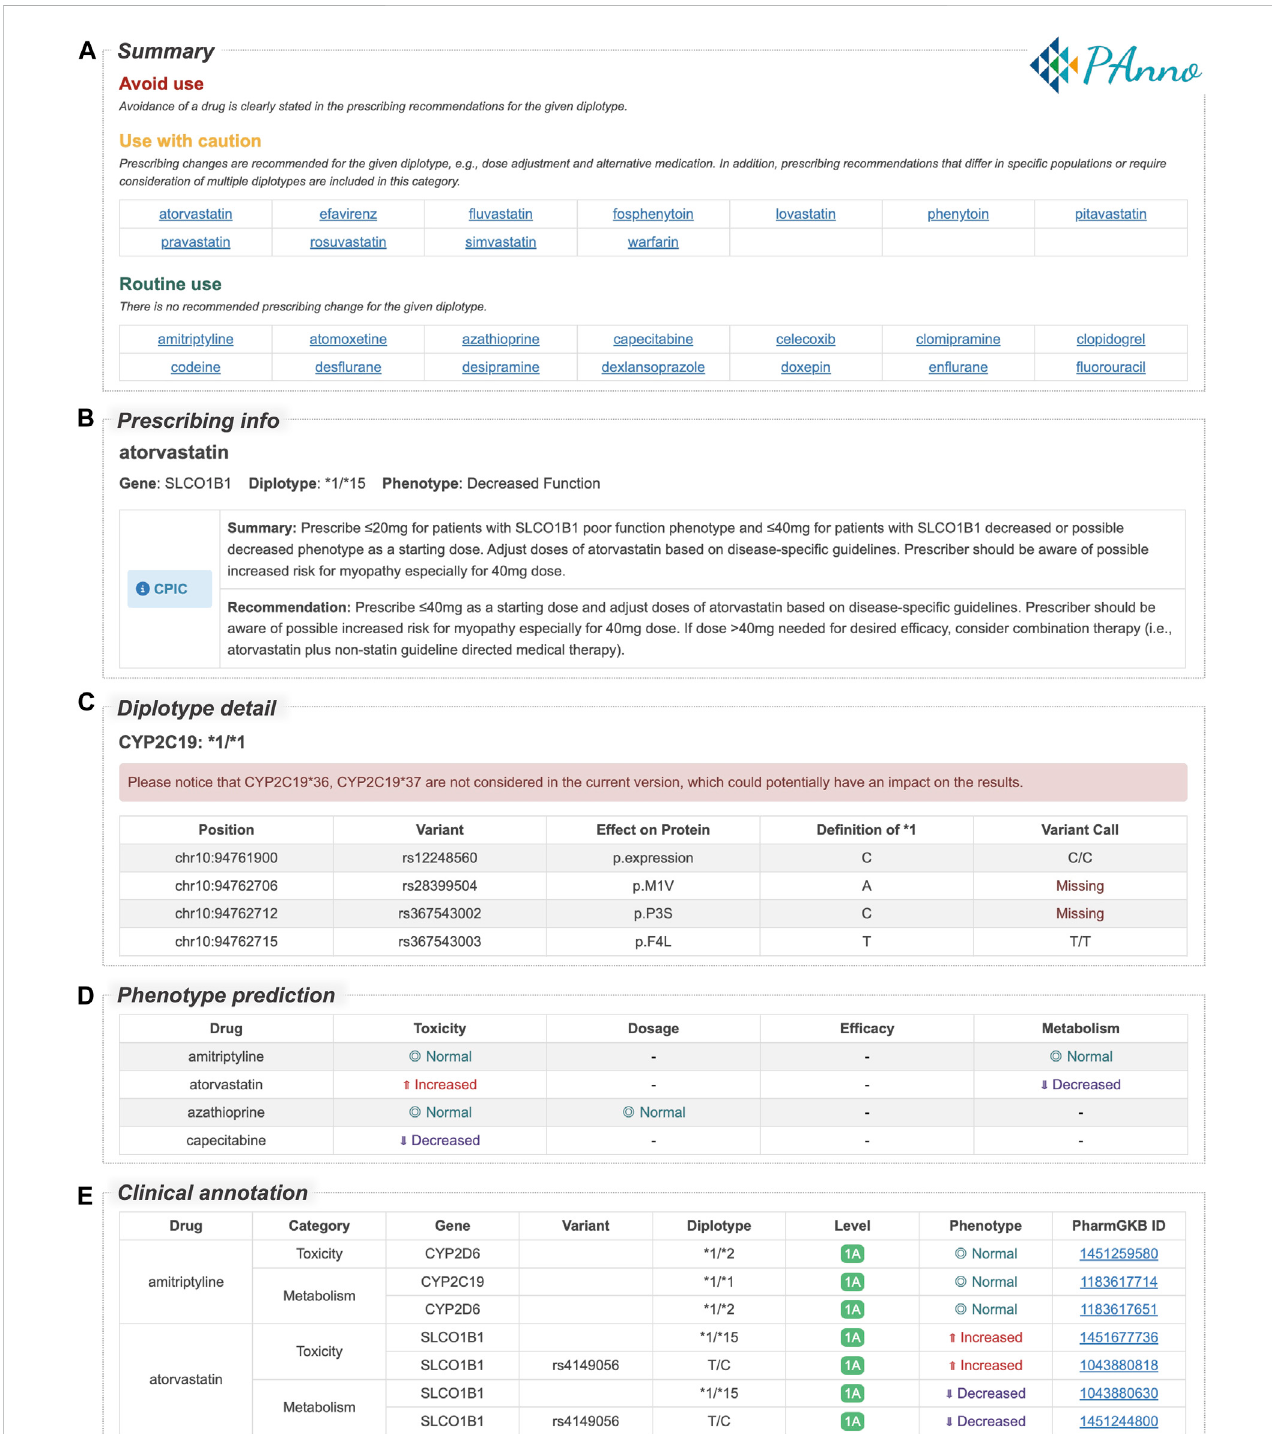
FIGURE 5 PAnno report sections for the 1000 Genomes Project VCF fi le of NA10859. PAnno report consists of fi ve sections. (A) Summary. Drugs are classed into three categories based on whether clinical guidelines recommend a prescribing change for the given diplotypes, i.e., avoid use, use with caution, and routine use. (B) Prescribing info. For each drug, this section lists the associated gene, diplotype, phenotype, and recommendations in CPIC, DPWG, CPNDS, and RNPGx. (C) Diplotypedetail.Thetablecontainsthedetectionoflociassociatedwiththede fi nitionofdiplotypes. (D) Phenotypeprediction.Theeffectsof multiple diplotypes for each clinically available drug in terms of toxicity, dosage, ef fi cacy, and metabolism are described. (E) Clinical annotation. The original annotations for the predicted phenotypes in the previous section are presented in the table. Full HTML report of NA10859 is available in Supplementary Material